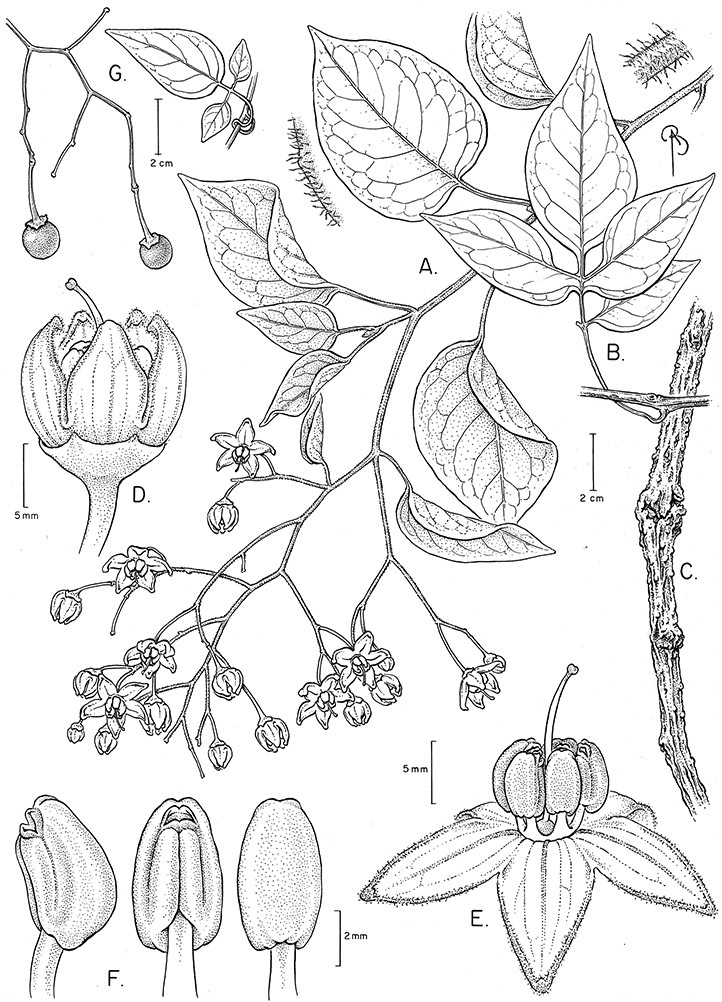
Solanum dulcamaroides Poir. (A drawn from Saunders 8220
B drawn from Nee 23837 C drawn from Nee 23735
D–F drawn from Cortés 29
G drawn from Lopez 340). Illustration by Bobbi Angell.